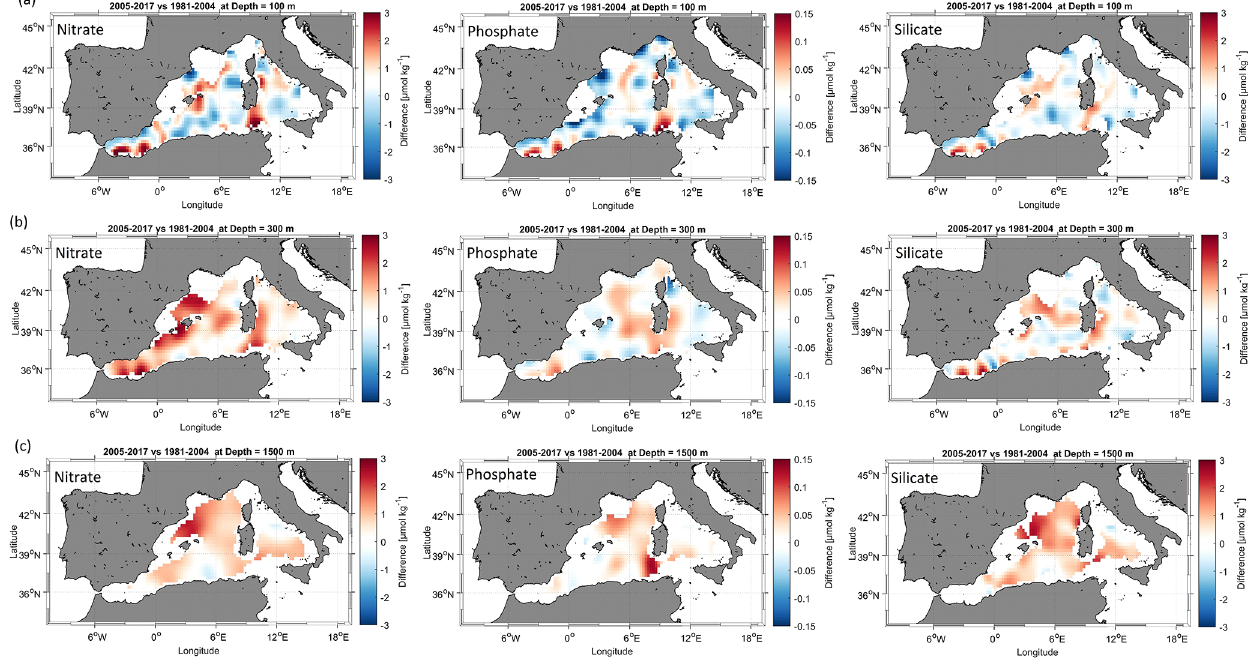
Figure C1. (a) Difference field at 100m between the 1981–2004 climatology and the 2005–2017 climatologies; (b) difference field at 300m; (c) difference field at